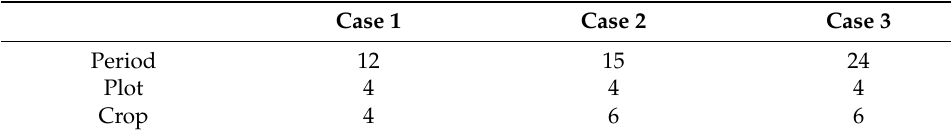
Table 4. Details of the planning problem for each case.